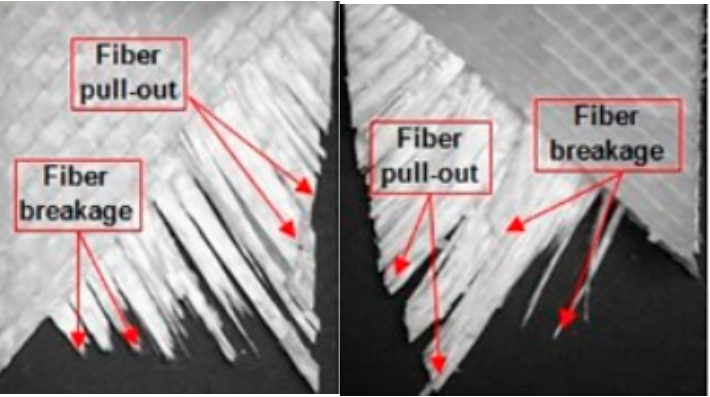
Figure 6. Post-effects of long-term loading due to creep failure of glass fibre-reinforced thermosetting polymer composites [88].